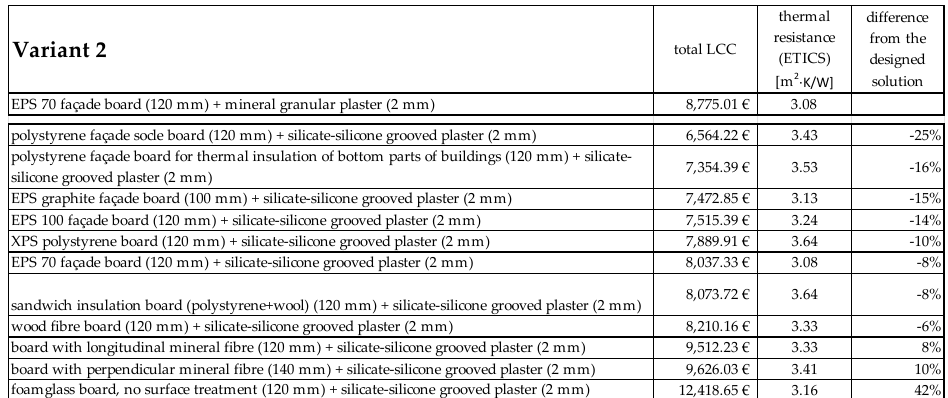
Figure 5. Output of the LCC calculation for Variant 1.